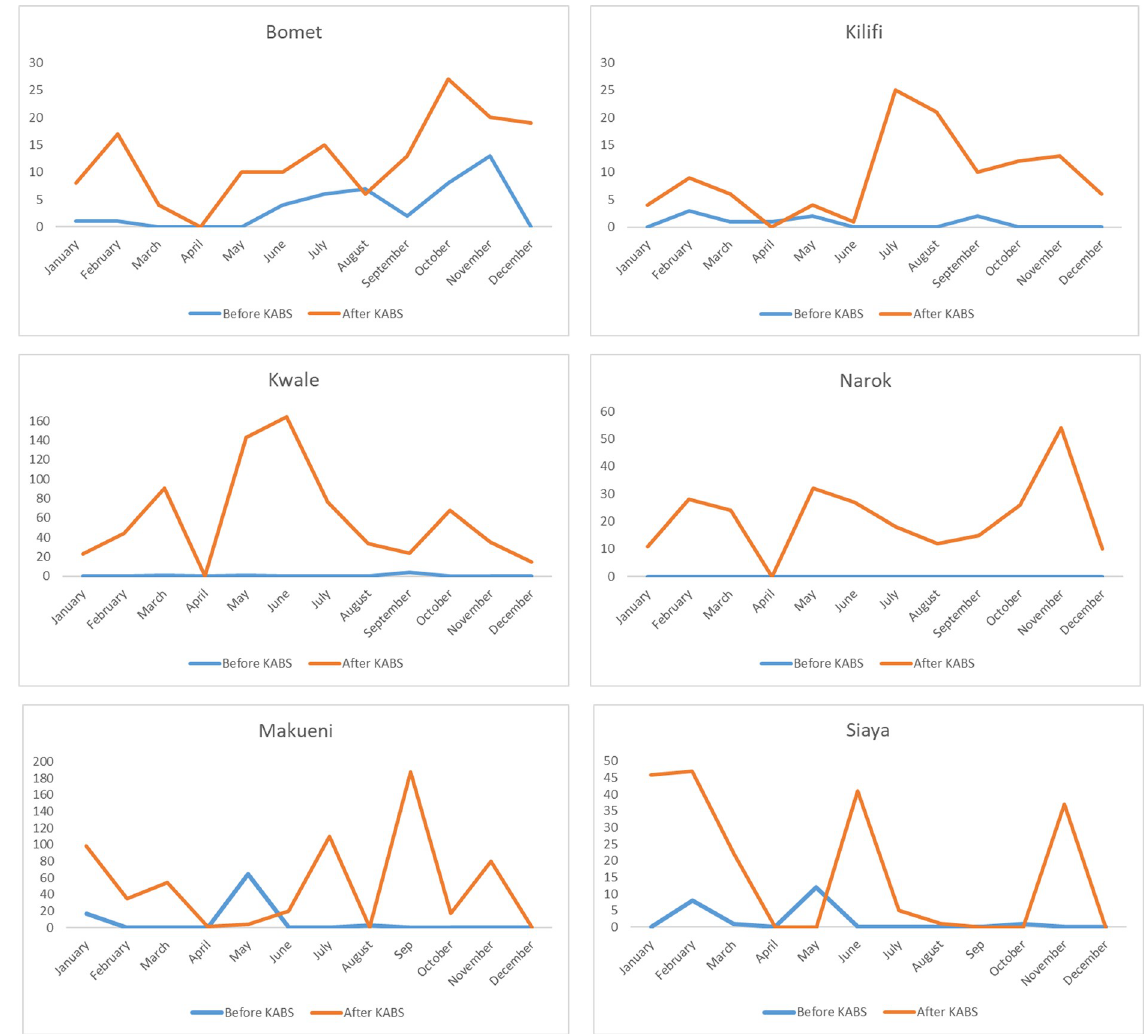
Fig 2. Frequency of disease reporting before (blue line) and after (red line) KABS mobile phone application introduction in Bomet, Kilifi, Kwale, Makueni, Narok, and Siaya counties of